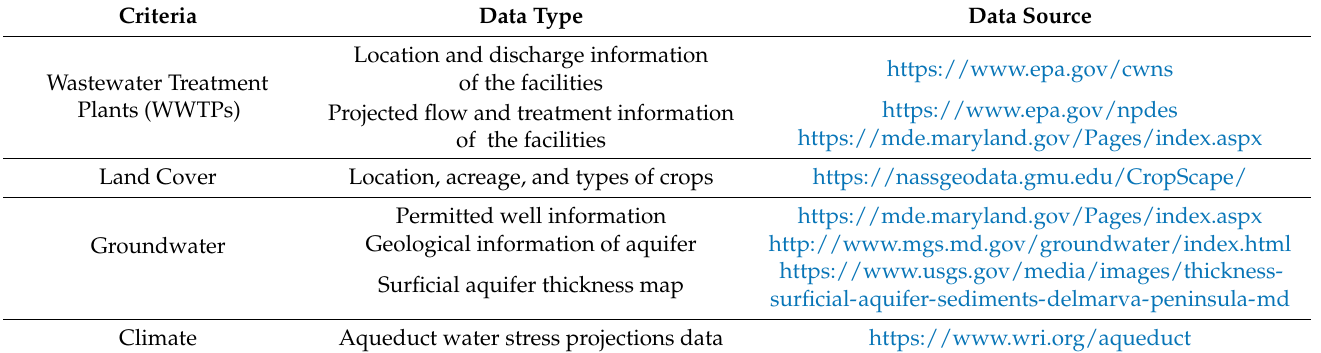
Table 1. List of datasets used in this